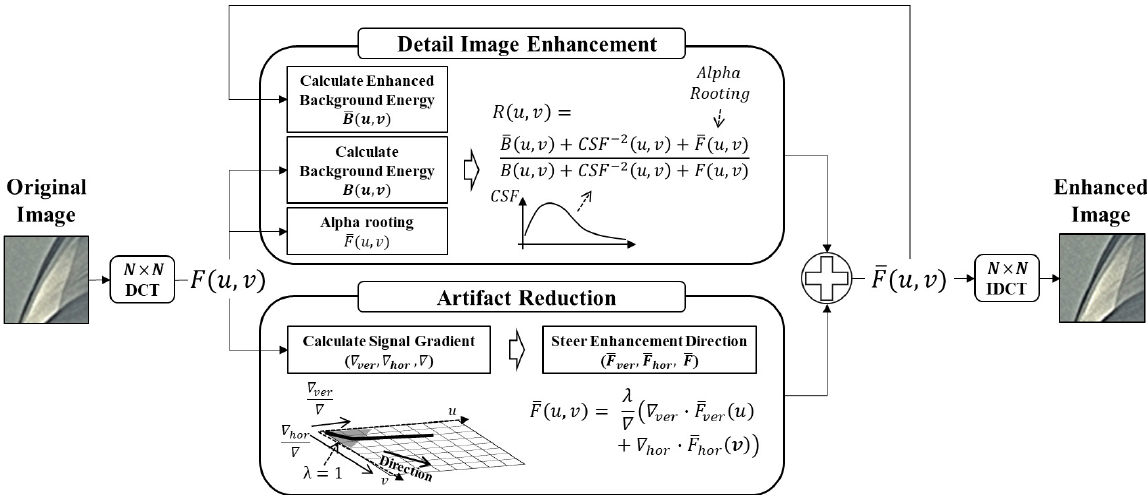
Figure 6. Overview of the proposed detail image signal